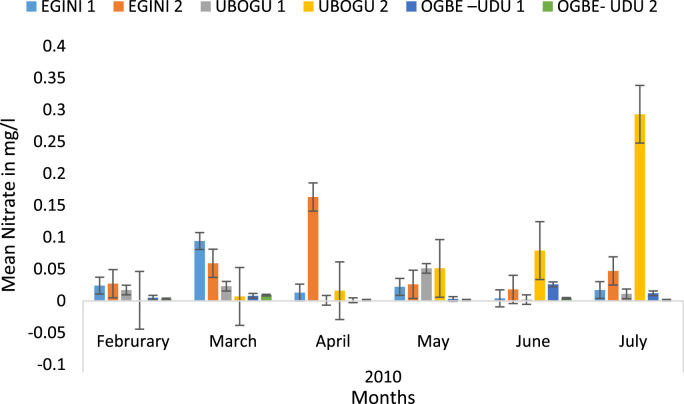
Mean Temporal and spatial variations in nitrate.